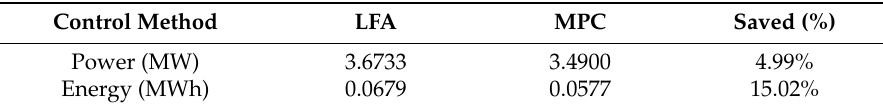
Figure 9. Experiment result of fluctuation suppression for the microgrid. Table 3. Power and energy requirements.